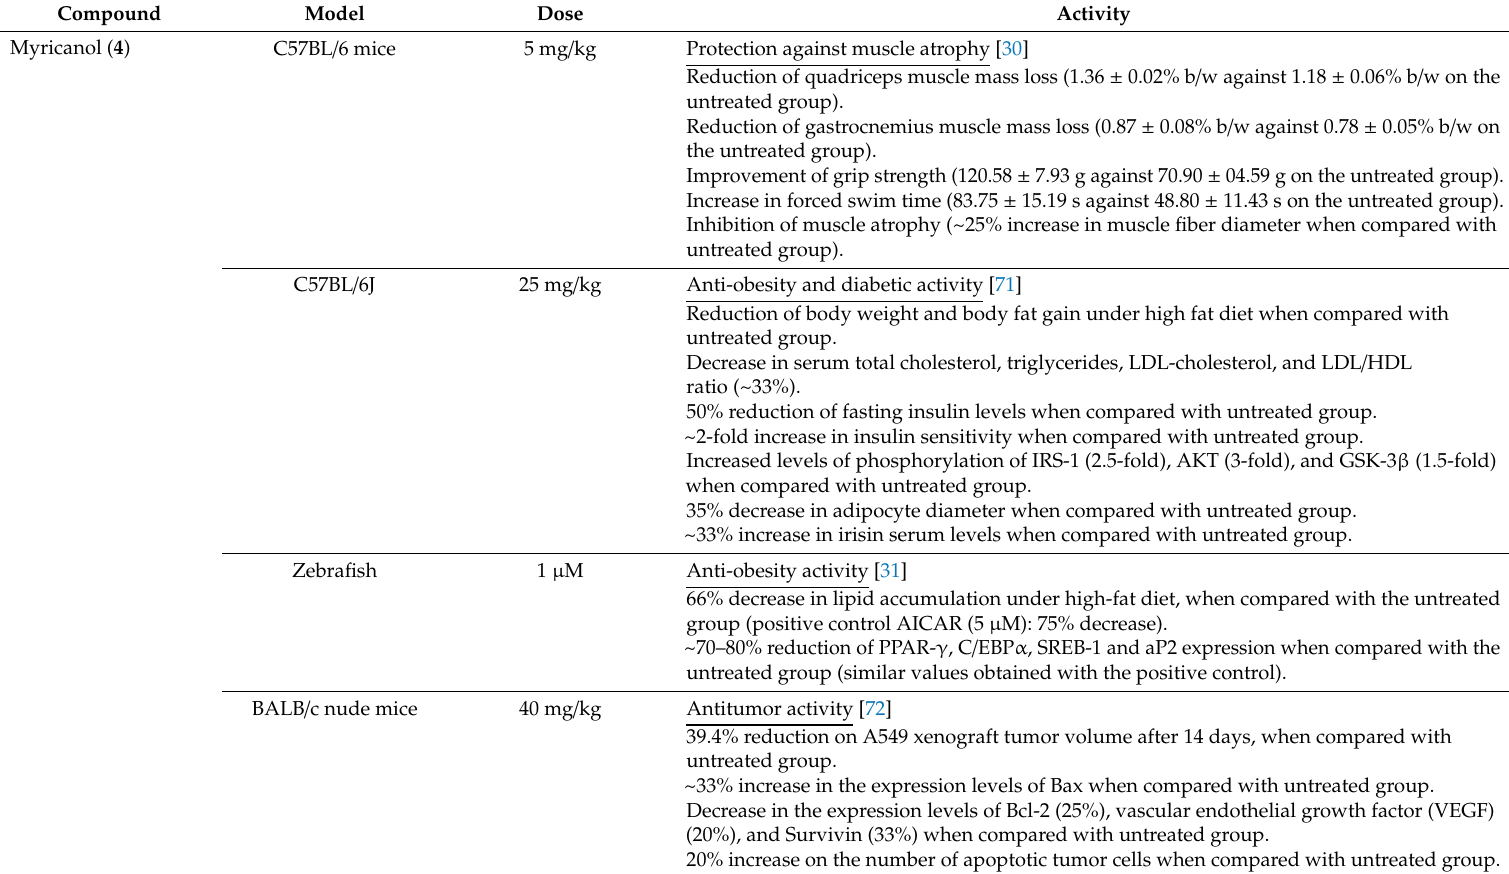
Table 2. In vivo biological activities exhibited by compounds from Morella and Myrica